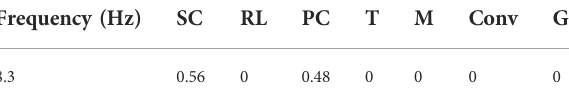
(SC-series capacitor in compensated transmission line, RL-resistance and reactance in compensated transmission line, PC-parallel capacitor, T-transformer, M-multimass, Conv-convertor, G-generator).